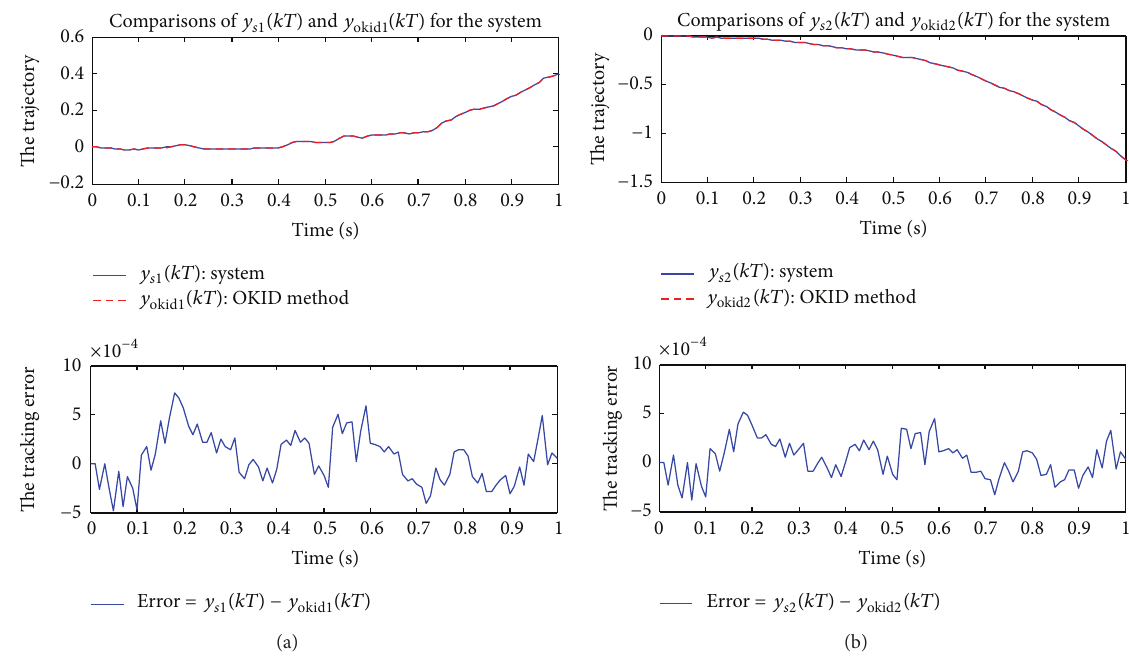
(𝑘𝑇) by OKID. (b) The comparison okid 1 (𝑘𝑇) by OKID. okid 2